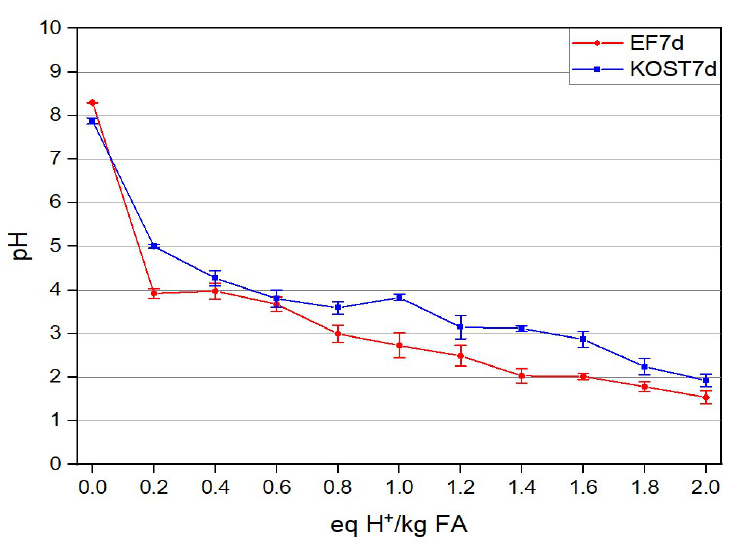
Figure 5. ANC test results of EF 7d and KOST 7d samples.